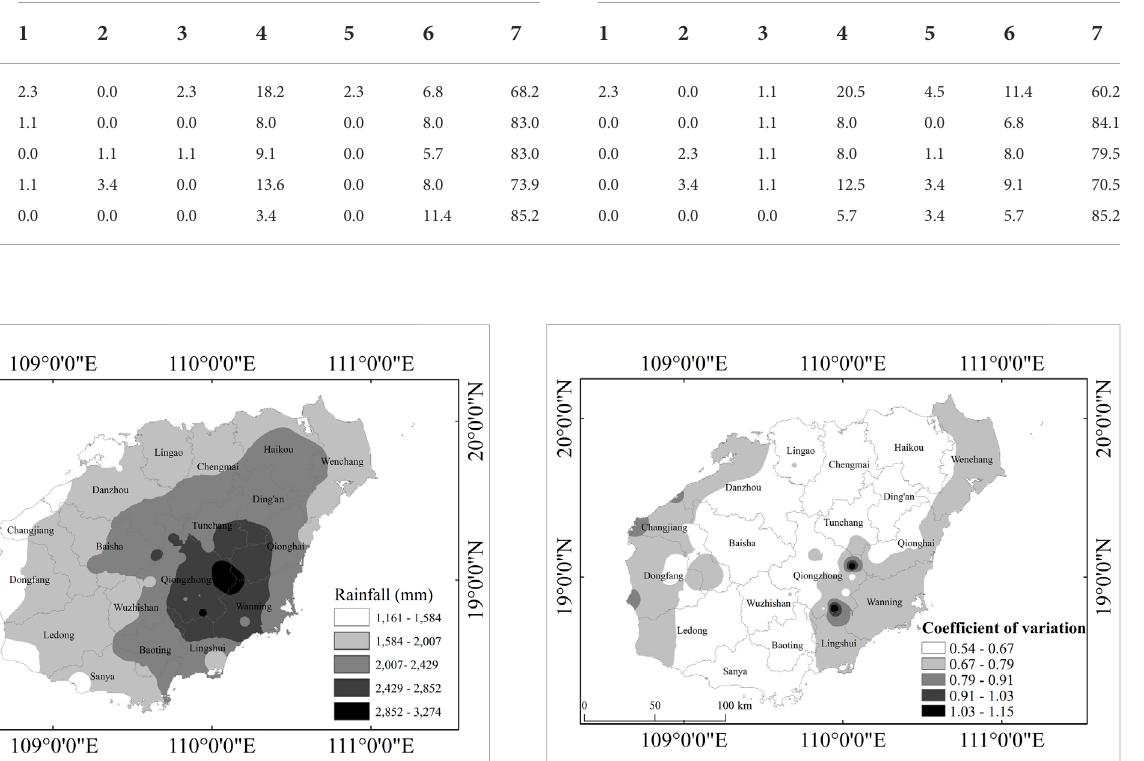
FIGURE 3 Spatial distribution of coef fi cient of variation in Hainan